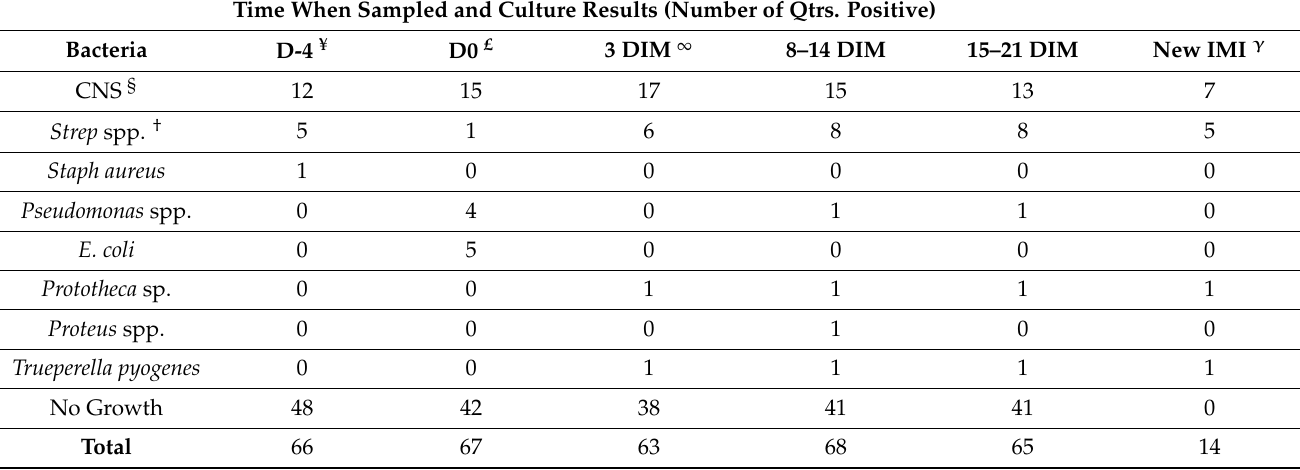
Table 1. Bacteria isolated from all milk cultures before dry-off and after calving. Time When Sampled and Culture Results (Number of Qtrs. Positive)